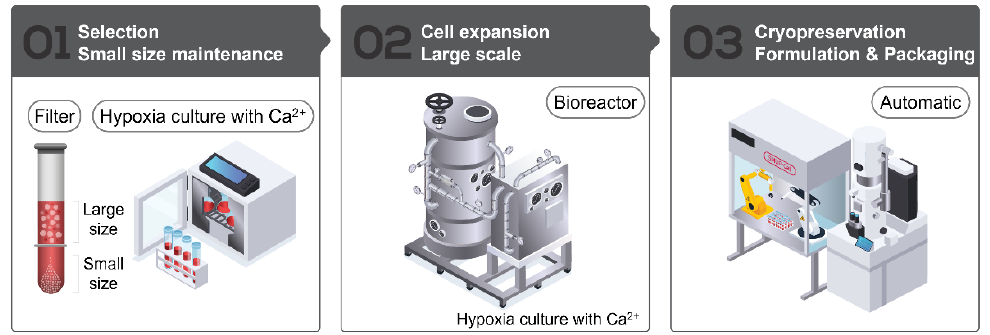
Figure 1. Summary of the SMUP-Cell platform. Selection step 01: isolation of small-sized cells cultured under hypoxic conditions in a calcium-rich medium. Cell-expansion step 02: scale-up using a bioreactor under the same culture conditions. Cryopreservation step 03: automated formulation and packaging with a xeno-free solution.